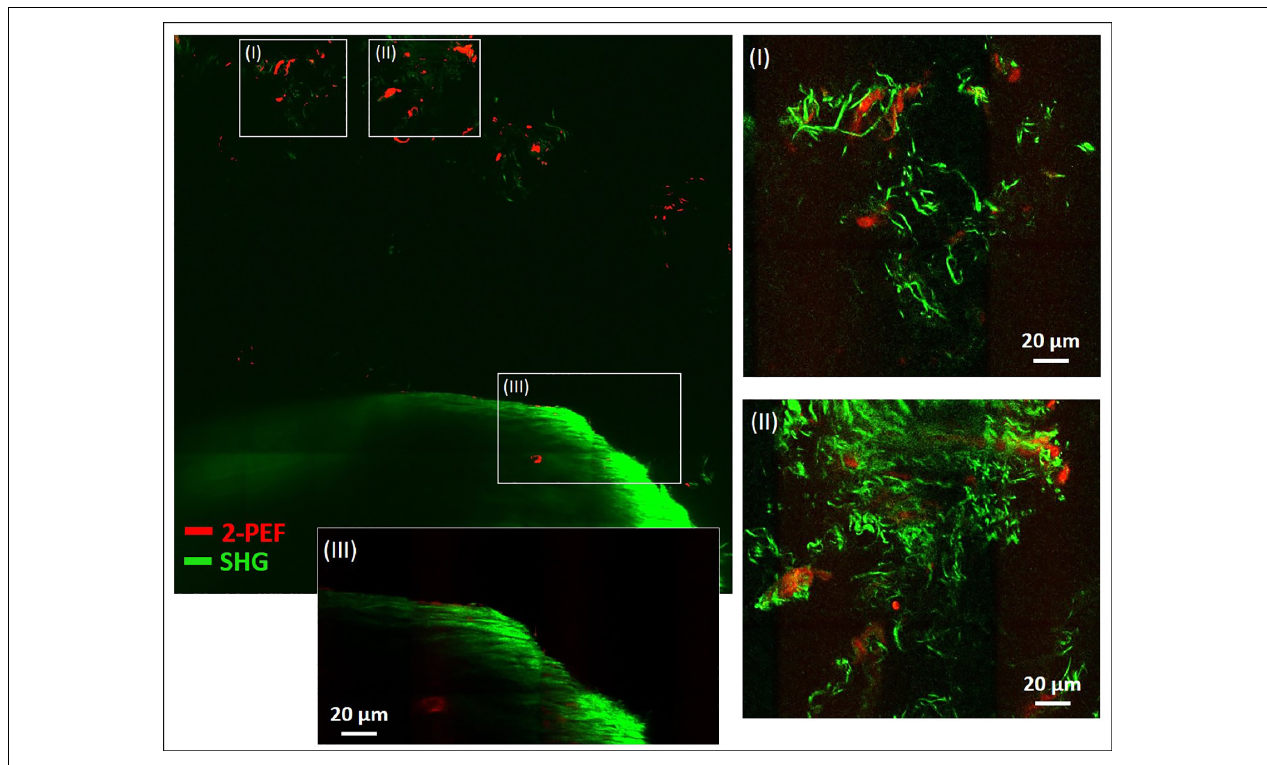
FIGURE 4 | Combined multiphoton 2-PEF/SHG large-scale image of decalcified metatarsus region of mouse. Overview image (8 × 8 images, 1,136 µ m × 1,136 µ m) with enlarged regions (I–III) adapted for brightness and contrast. In panels (I) and (II) the collagen-I network is highly resolved with various fiber morphologies and arrangements. In panel (III) the periphery of the large object is enlarged and shows rather uniform fiber morphology typical for cortical bone. 2-PEF: cells/remaining HA crystals. SHG: collagen-I fiber